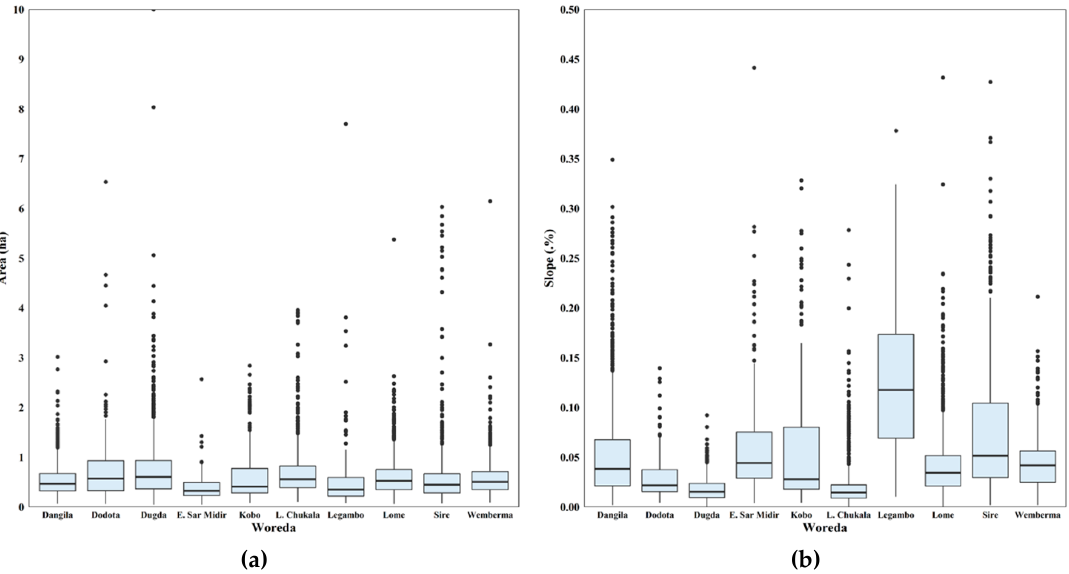
Figure 7. Boxplots showing the distribution of field boundary area ( a ) and average slope ( b ) as defined in REF for each Woreda. Slope was derived from the CGIAR CSI SRTM 90 m Digital Elevation Database v4.1 (https://cgiarcsi.community/data/srtm-90m-digital-elevation-database-v4-1/).